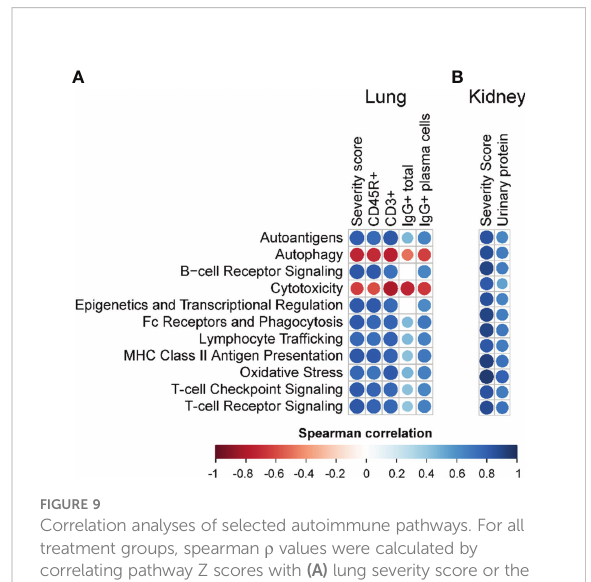
FIGURE 9 Correlation analyses of selected autoimmune pathways. For all treatment groups, spearman r values were calculated by correlating pathway Z scores with (A) lung severity score or the percent positive staining for CD45R + , CD3 + , or IgG + in lung tissue or IgG + in lung tissue plasma cells; or (B) kidney severity score, kidney blood urea nitrogen (BUN), or kidney urinary protein. Signi fi cant correlation values (p<0.05) are represented as circles colored by the correlation value (blue, positive; red, negative); non-signi fi cant correlations are indicated by blank